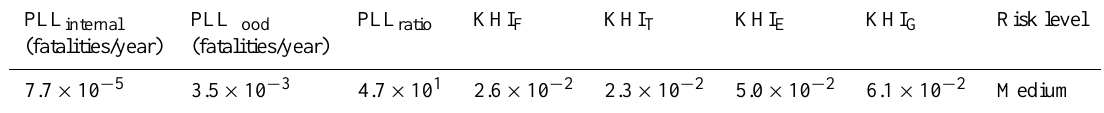
Table 3. Risk indexes obtained from QRA (PLLs [28]) and from the presented methodology (KHIs) for case study 1.